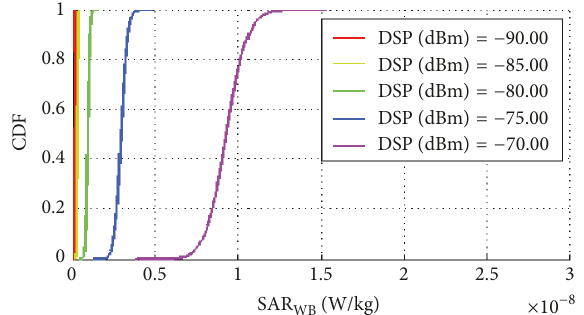
Figure24:CDFsofSAR inducedbythedownlink(5planewaves) WB at 900 MHz for various values of DSP.